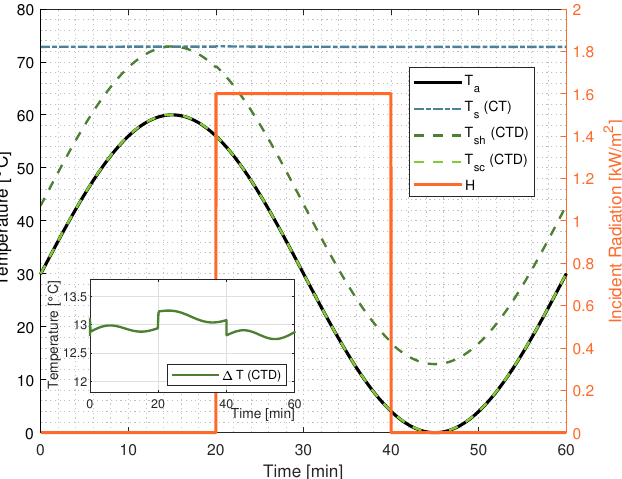
Figure 9. CT and CTD architectures’ sensor temperatures from SPICE simulations.